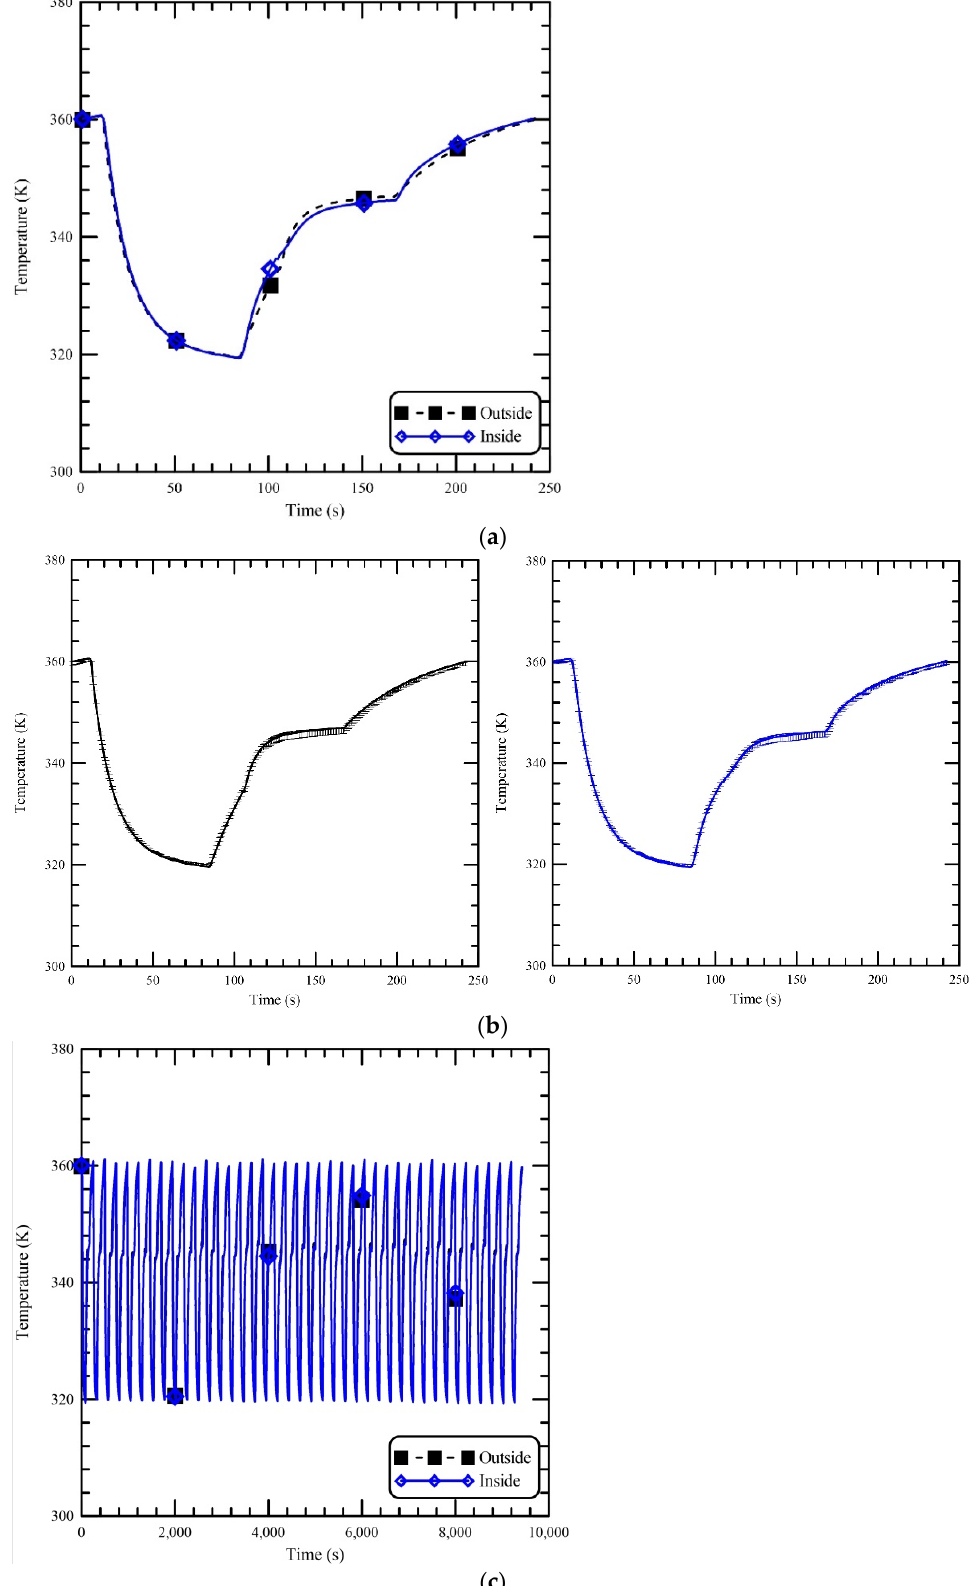
Figure 7. ( a ) The accuracy, ( b ) the repeatability and ( c ) the stability of the thermal characteristics are examined in our oscillating thermocycler.